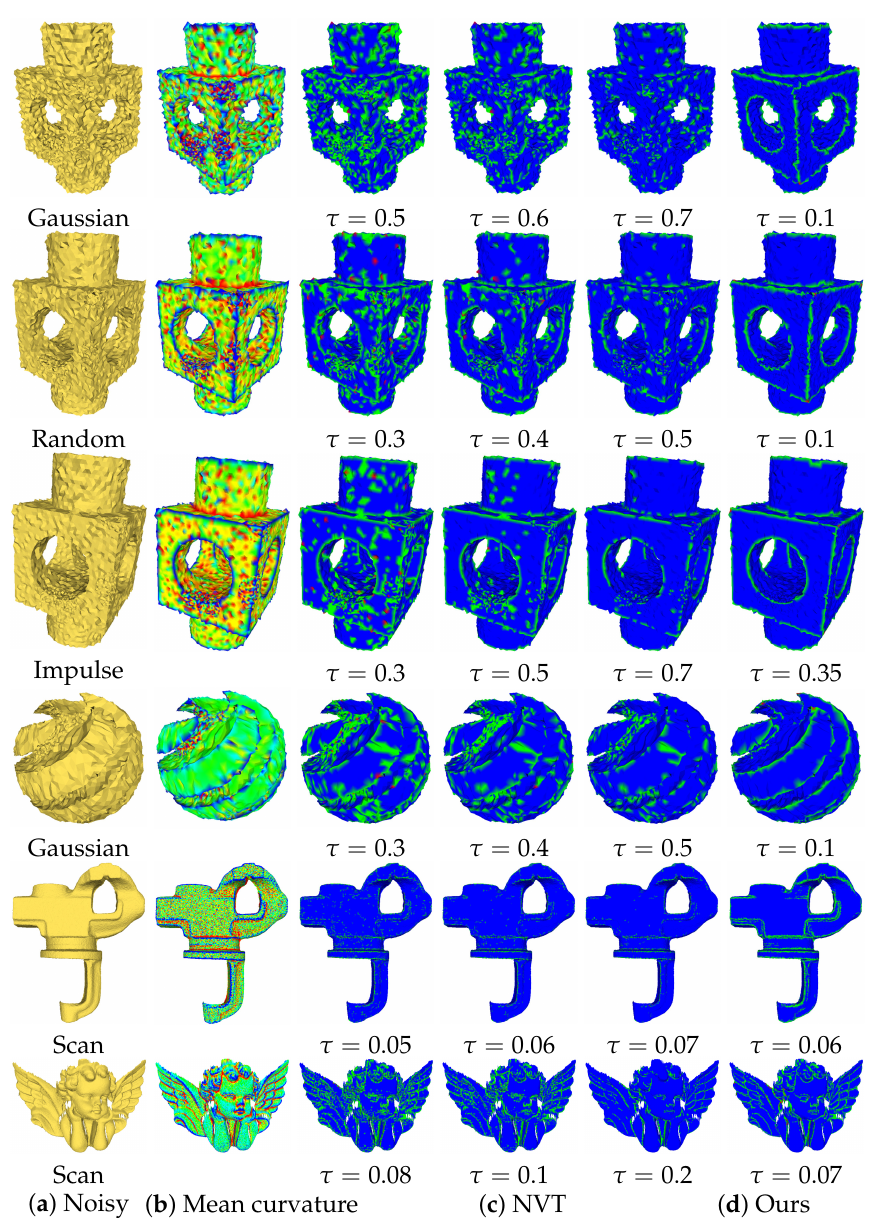
Figure 11. Comparison of feature point classification for the CAD and scan